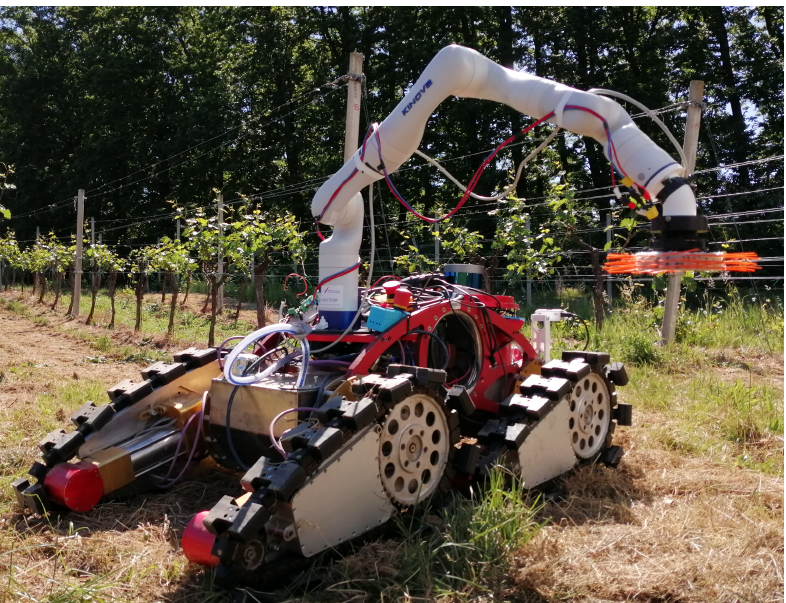
Figure 2. Mobile manipulator developed as a part of the HEKTOR project. Direct drive brush-shaped tool is mounted as a robotic manipulator